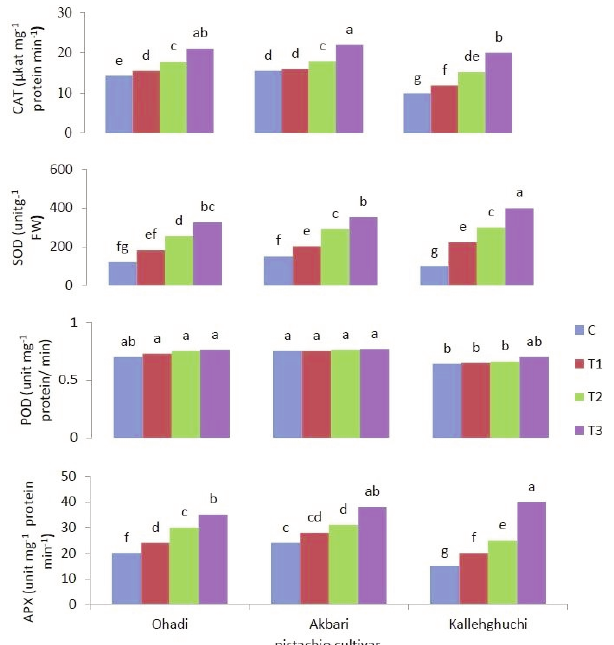
Fig. 1 - Interaction of stage of brassinostroides application and cultivar for the activities of some antioxidant enzyme of pistachio in the “on” year. C= Control, T1= Bud swelling phase, T2= two weeks after full bloom, T3= T1 and T2. Different letters within a row indicate significant differences by Duncan’s multiple range tests at P<0.05.